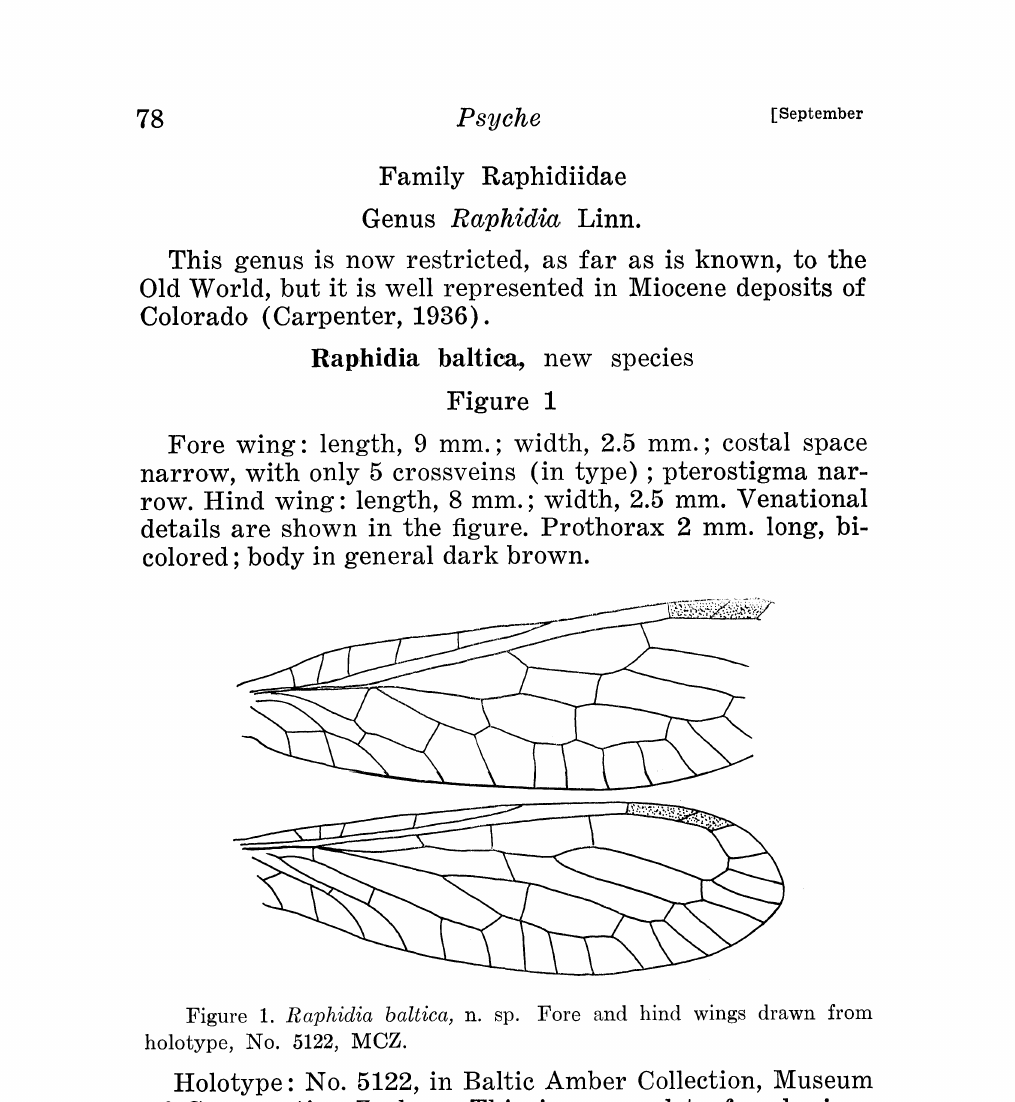
Figure 1. Raphidia baltica, n. sp. Fore and hind wings drawn from holotype, No. 5122,